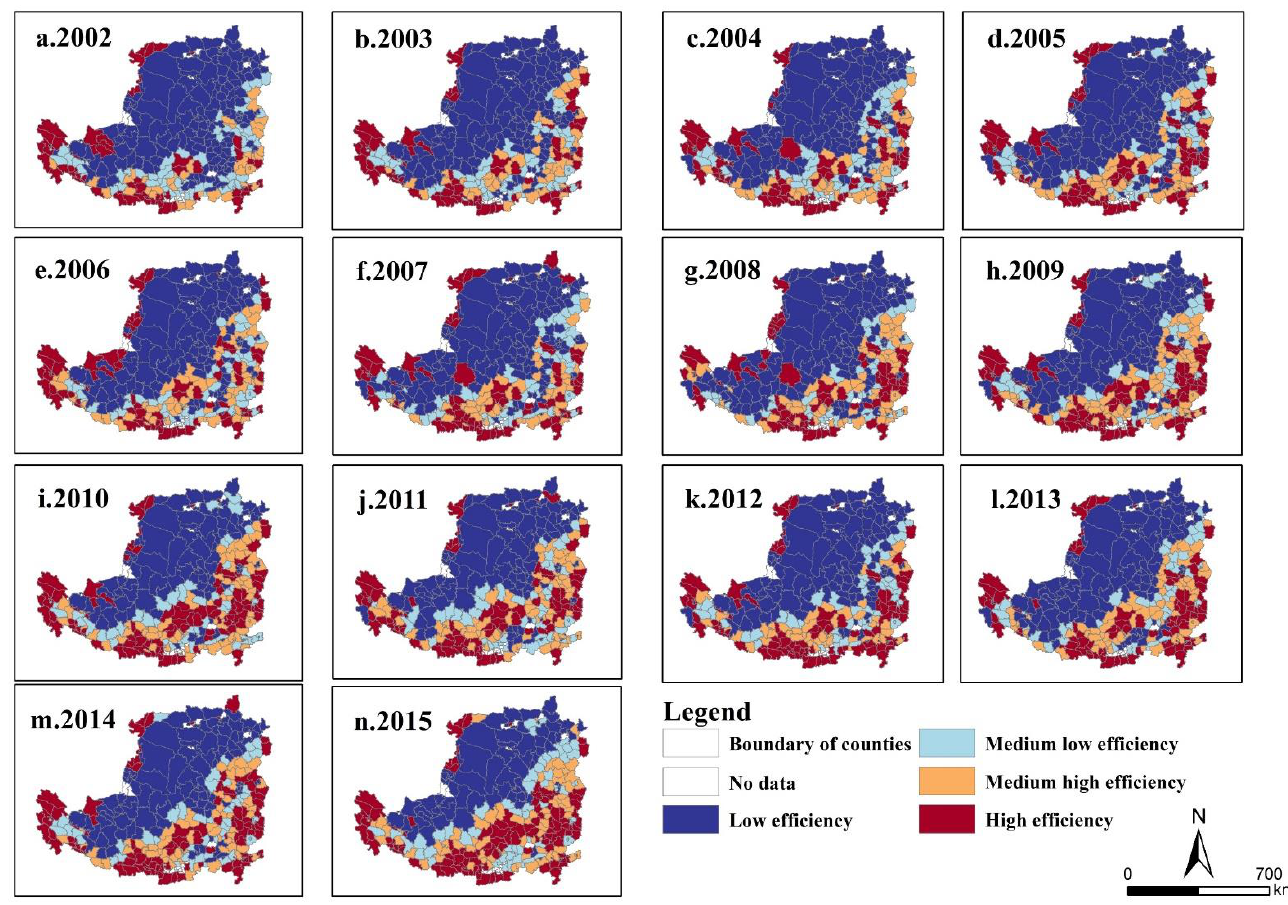
Figure 6. Spatial distribution of EEoSLCP by counties in the LP from 2002 to 2015.